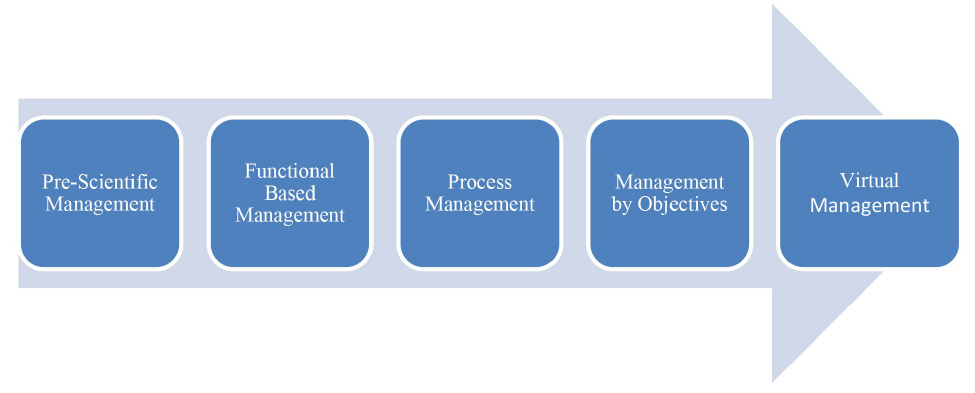
Figure 2. Evolution of Managerial